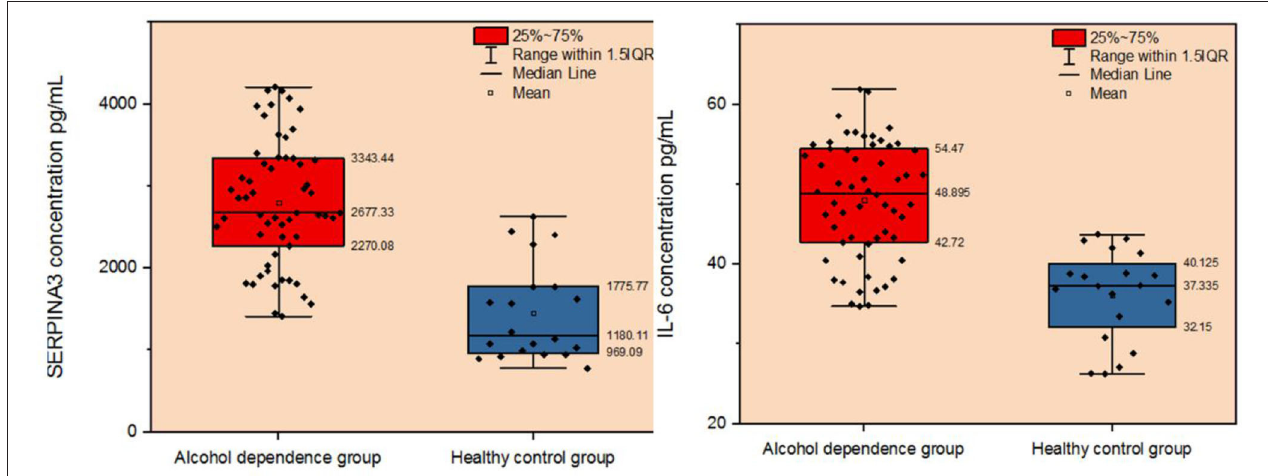
FIGURE 5 | Comparison of plasma SERPINA3 and IL-6 levels between patients with alcohol dependence and the healthy control group.